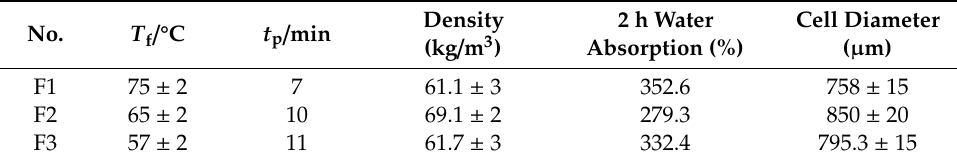
Table 2. Performance of the furanic-glyoxal